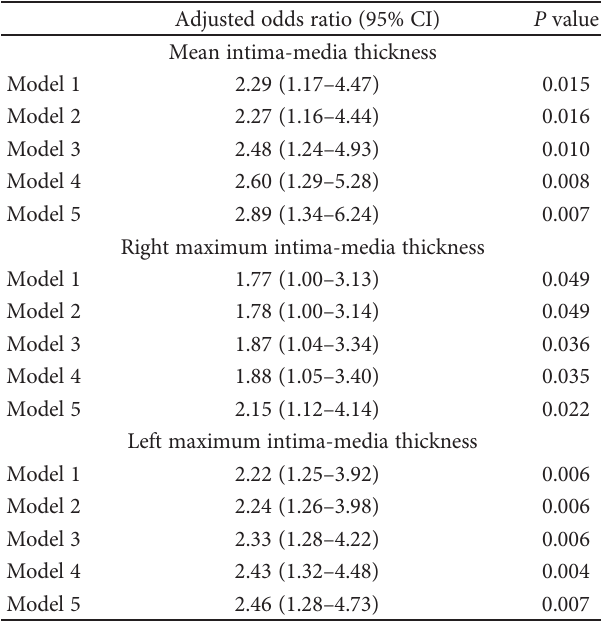
Table 3: Results of adjustment randomized